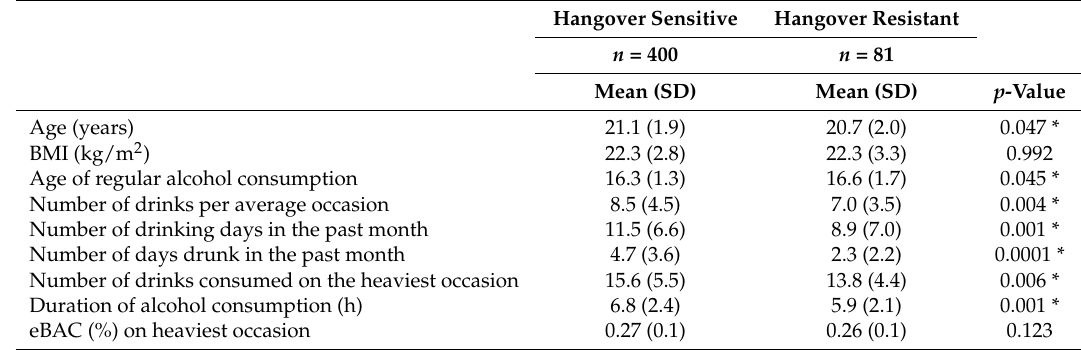
Table 1. Demographics of hangover-sensitive drinkers and hangover-resistant drinkers after achieving an estimated BAC of at least 0.18% during their heaviest drinking occasion in the prior month. Significant differences ( p < 0.05) between the groups are indicated with *. Abbreviations: BMI = body mass index, eBAC = estimated blood alcohol concentration. Hangover